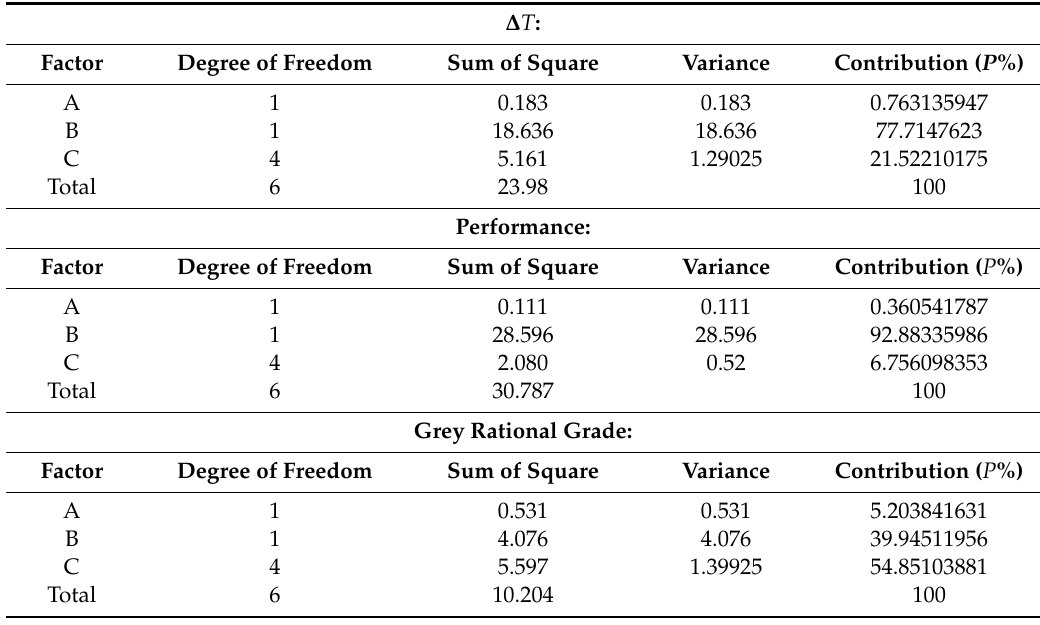
Table 7. The results of ANOVA conducted on S / N ratios of Tables 3 and